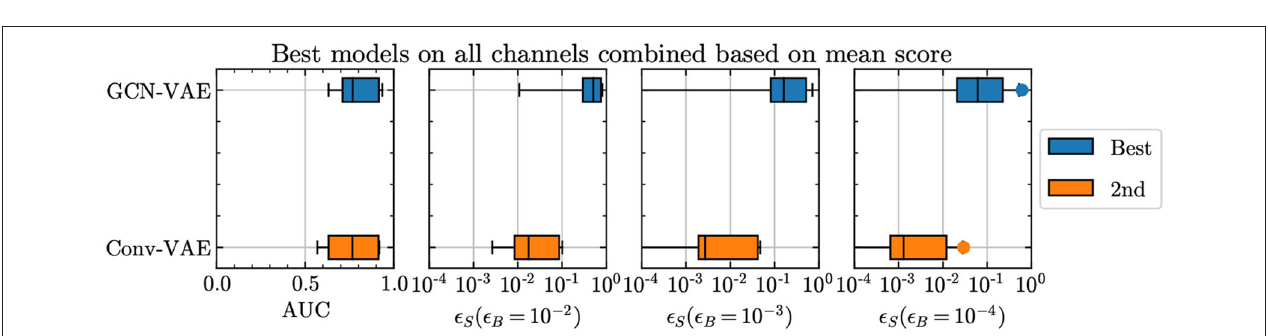
FIGURE 2 | Comparison of the GCN-VAE and Conv-VAE performances, in terms of the benchmark figures of merit adopted in the article.